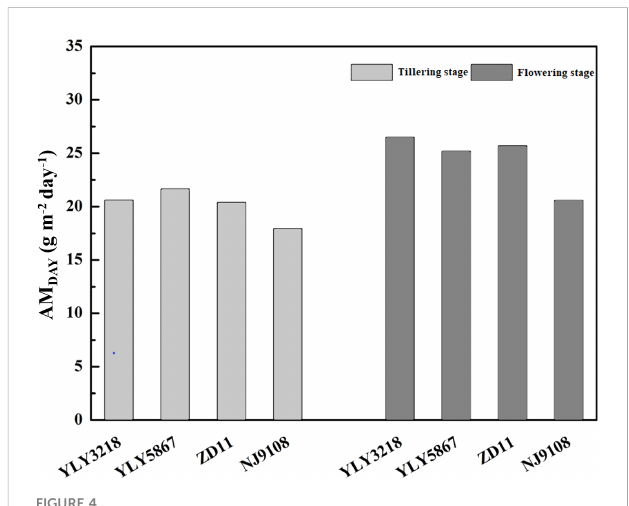
FIGURE 4 Daily aboveground biomass increment (AM DAY ) simulated by observed parameters for different rice cultivars during tillering and fl owering stage. Different letters mean signi fi cant differences ( P < 0.05) among rice cultivars during the same growth